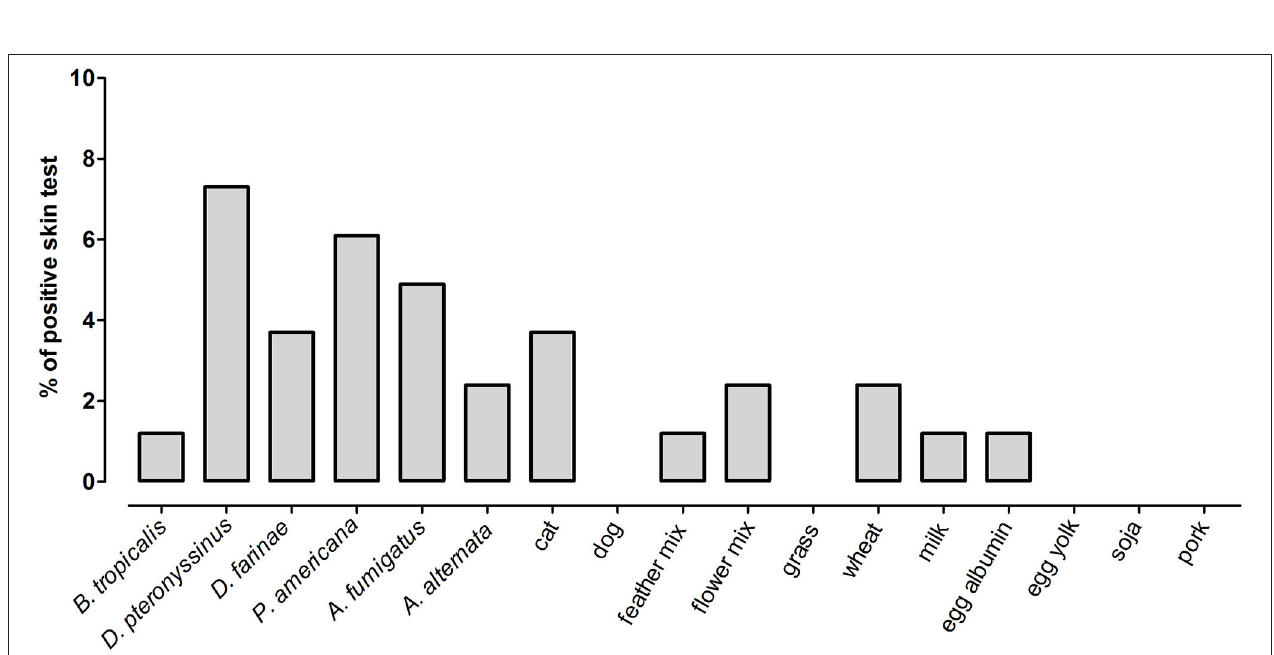
FIGURE 2 | Prevalence of positive skin tests to 18 allergens in a subset of wheezing children that returned 2 weeks after ER discharge ( n =